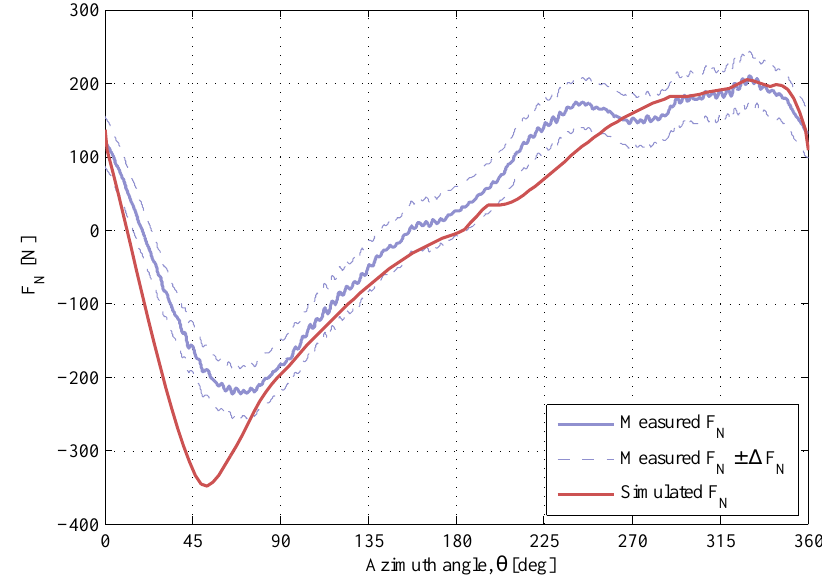
Figure 9. The normal force at λ = 1 . 84 , Ω = 40 . 29 rpm . The air density and the kinematic viscosity are ρ = 1 . 25 kg / m 3 and ν = 1 . 42 · 10 − 5 m 2 / s .